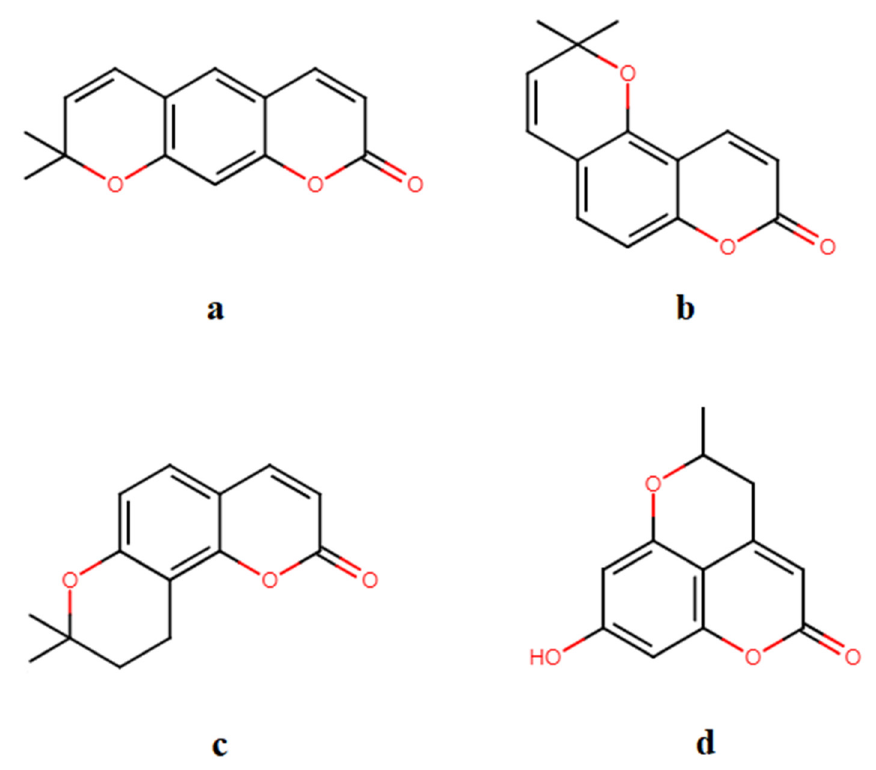
Figure 1. Natural groups of pyranocoumarins: ( a ) linear pyranocoumarin; ( b ) 5,6‑angular pyra‑ nocoumarin; ( c ) 6,7‑angular pyranocoumarin; ( d ) condensed pyranocoumarin.